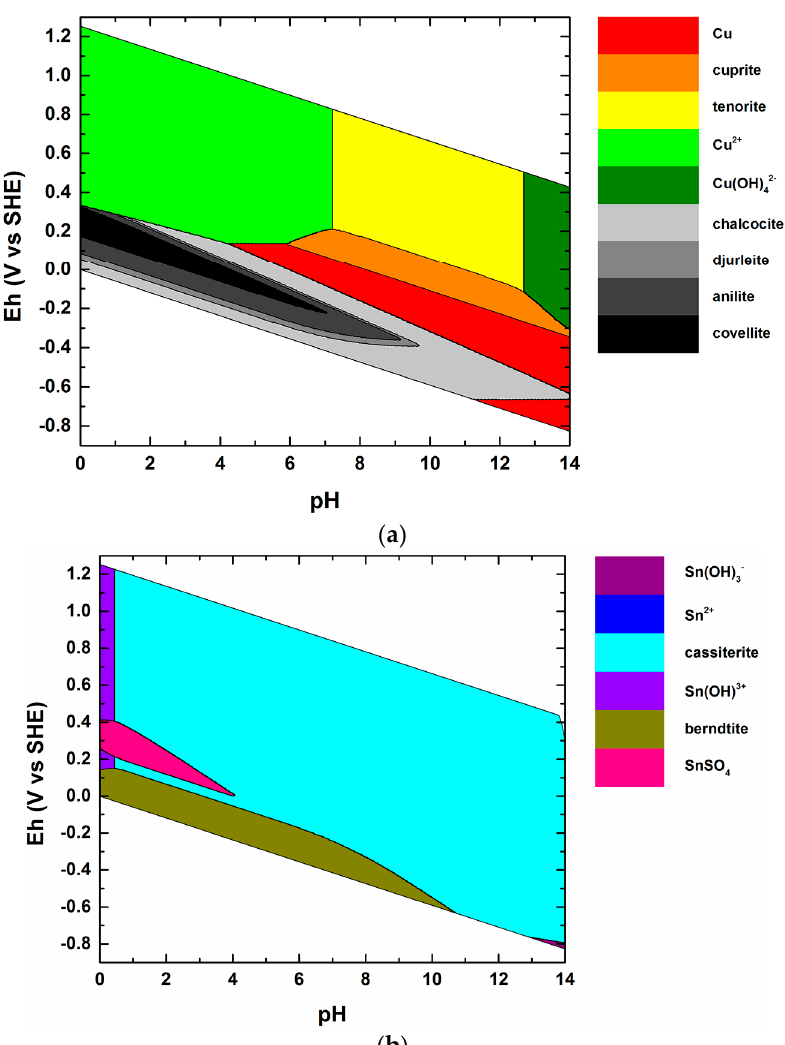
Figure 3. Eh-pH diagrams of: ( a ) the Cu–S–O–H system, calculated assuming [Cu] = 10 − 6 mol/kgw and [S] = 10 − 3 mol/kgw; ( b ) the Sn–S–O–H system, calculated assuming [Sn] = 10 − 8 mol/kgw and [S] = 10 − 3 mol/kgw.